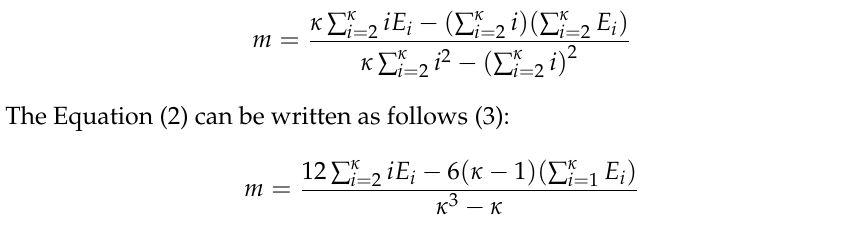
Algorithm 2. GRSA algorithm Procedure. 1: Data: T , T , T , E, S, α, ϕ, δ i fp f